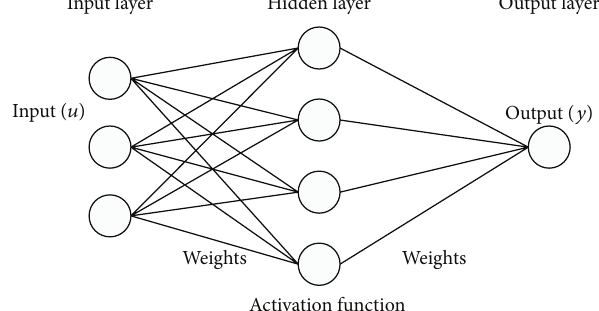
Figure 10: Sigmoid network